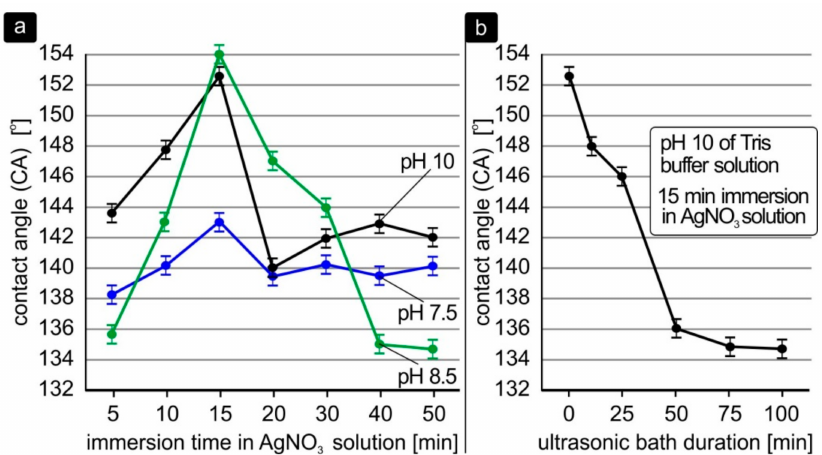
Figure 2. ( a ) Contact angle relative to the immersion time in silver nitrate solution and pH value of the Tris buffer solution, ( b ) contact angle after various durations in an ultrasonic bath for the optimum silver-coated superhydrophpobic copper